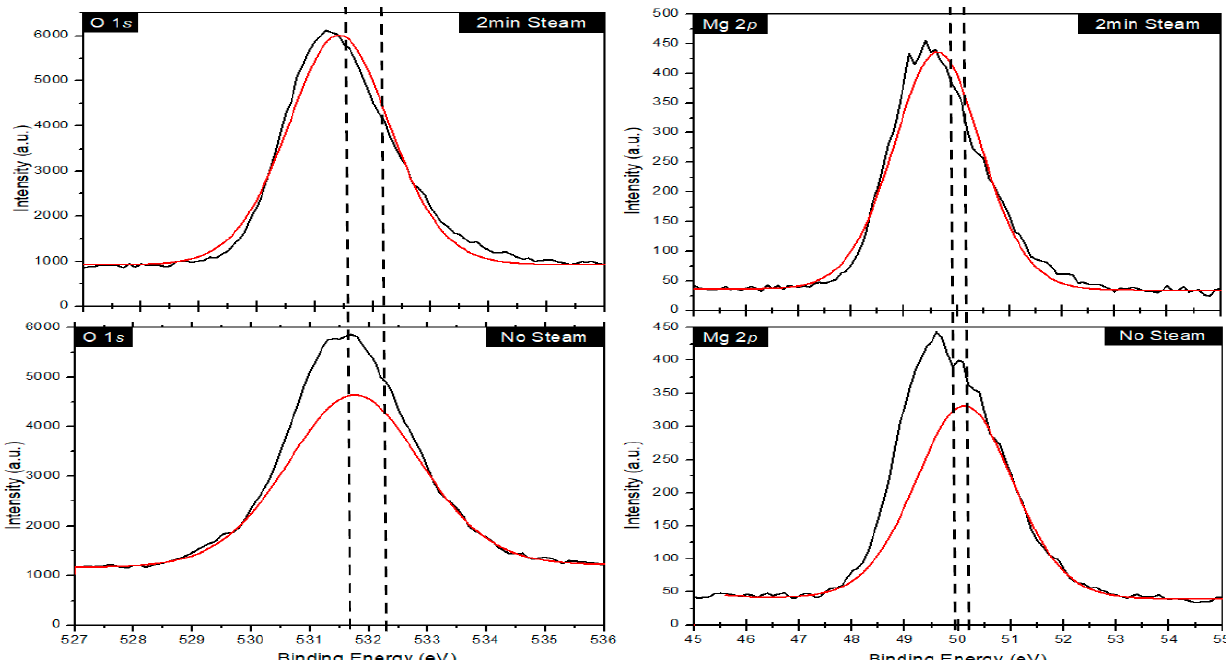
Figure 4. X-ray photoelectron spectra of the no-steamed and steamed samples. The no-steam sample is comprised of MgO, and the steamed samples at 100 °C show the formation of a MgO–Mg(OH) 2 composite structure.